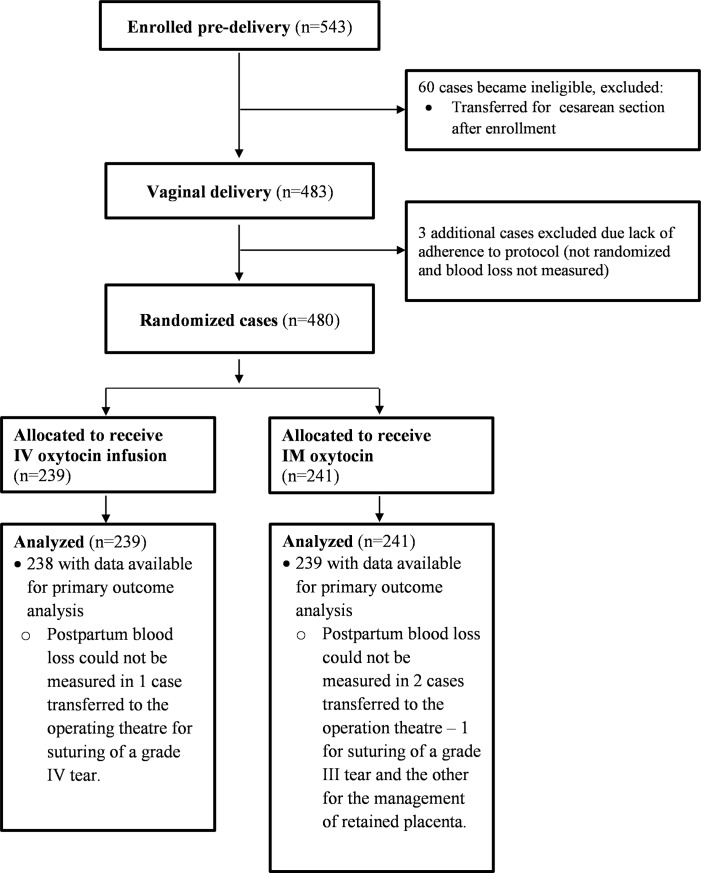
Consort flow diagram: Trial profile.